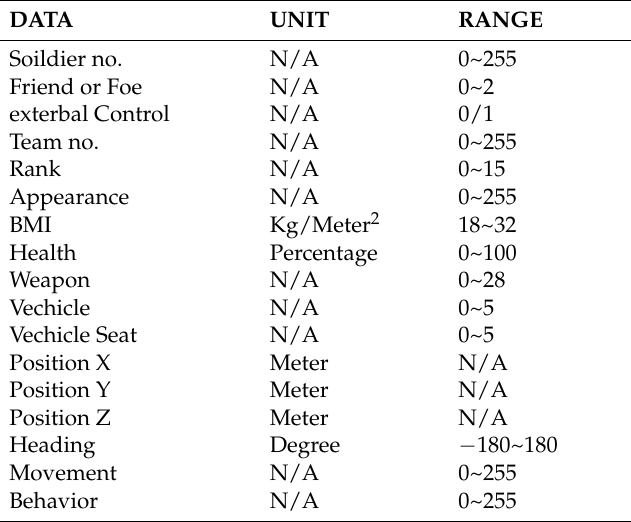
Table 3. Description of the features of each